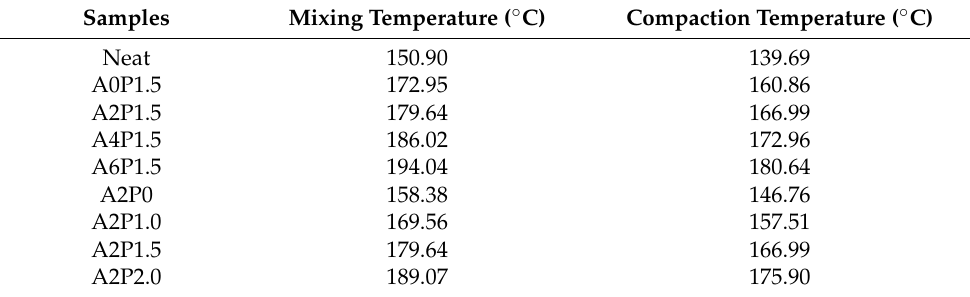
Table 6. The mixing and compaction temperatures for all